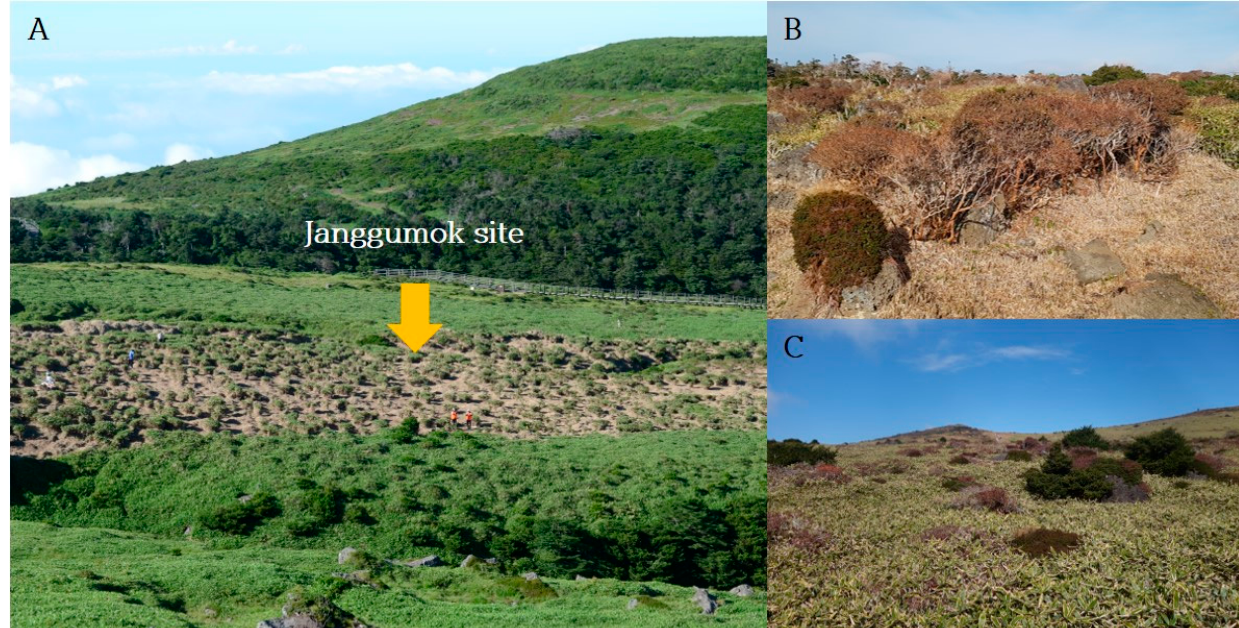
Figure 1. Overview of Janggumok where Sasa quelpaertensis was eliminated ( A ) and the growth condition of R. mucronulatum ( B ), and the control area where Sasa quelpaertensis was not eliminated at Seonjakjuwat ( C ).